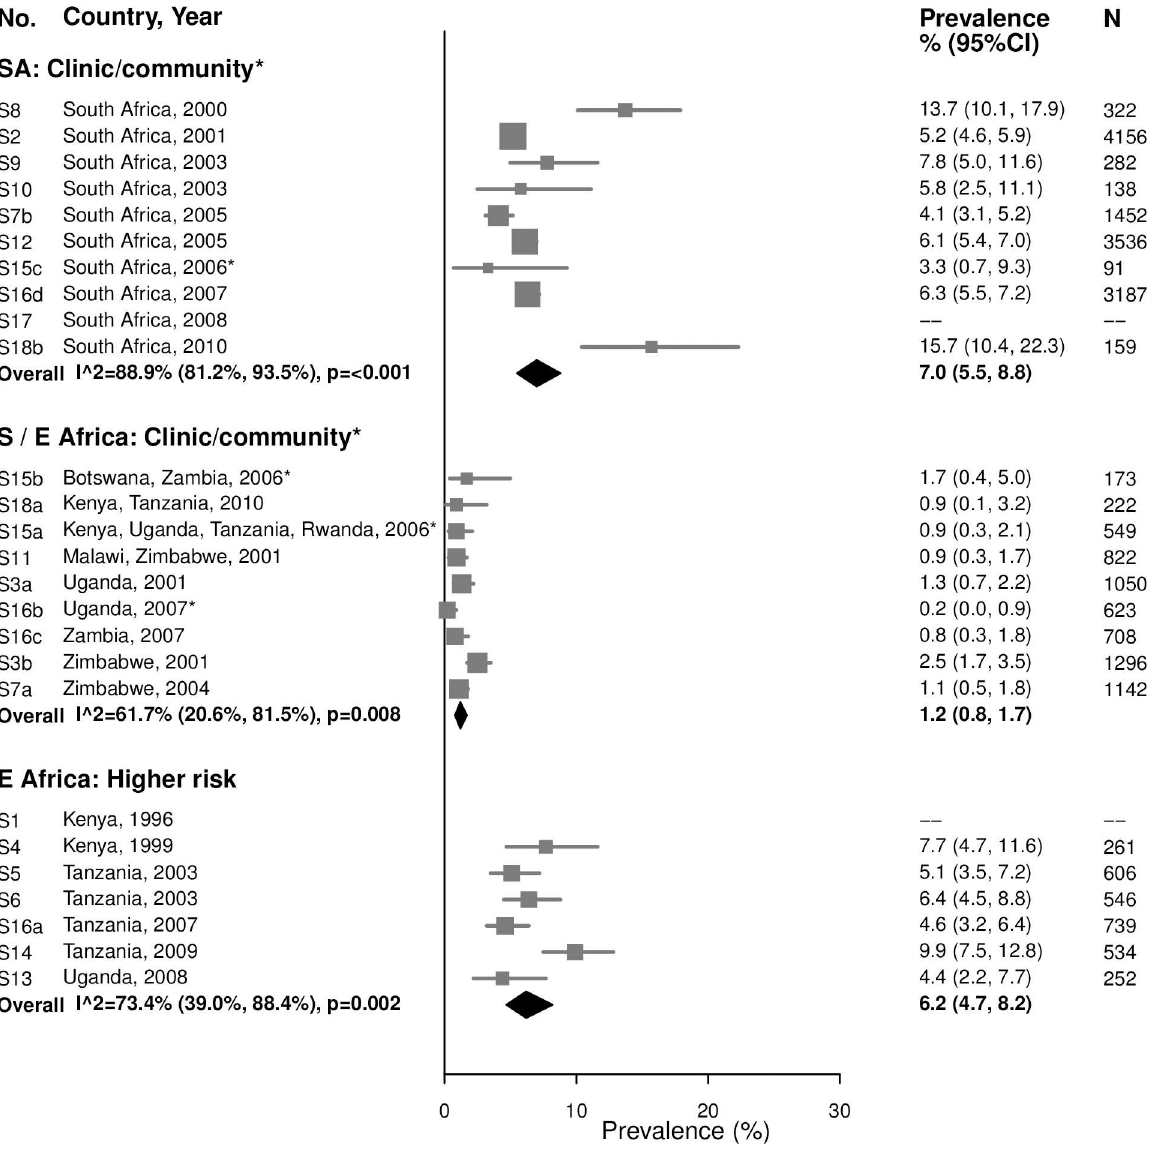
Fig 2. Chlamydia prevalence among 25–49-year-olds. The area of the marker is proportional to the square root of the sample size. Studies with no estimate presented did not meet the inclusion criteria for this infection and age group. Year presented is the median year that baseline data were collected during the study. (cid:3) Includes studies of HIV-discordant couples. E Africa, Eastern Africa; SA, South Africa; S/E Africa, Southern and Eastern